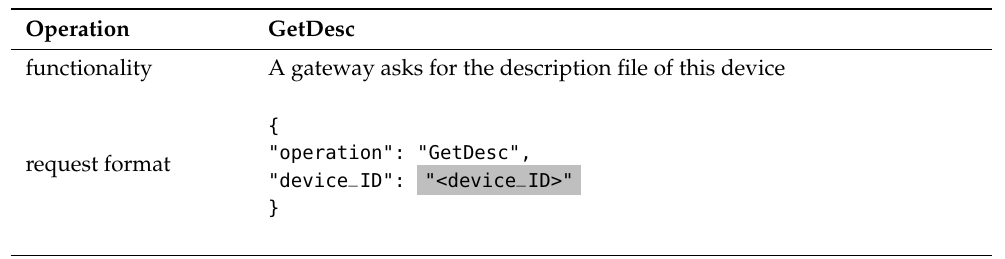
Table 9. GetDesc operation.